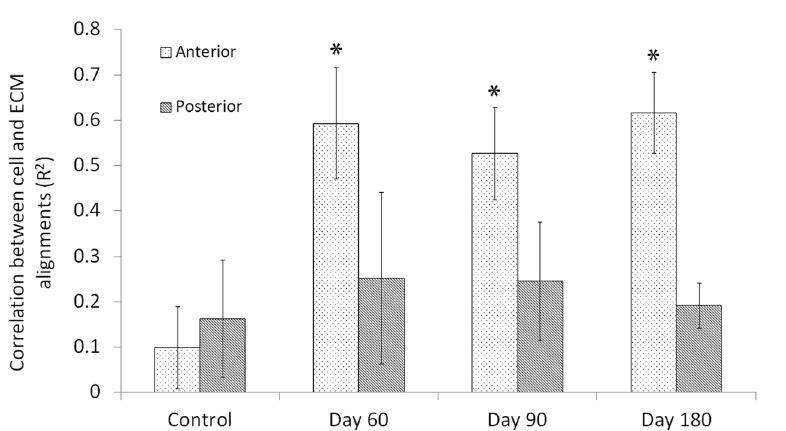
Figure 8. Quantitative analysis of cell/ECM co-alignment in the pre-operative anterior control stroma (control), regenerative anterior stroma (day 60, 90, and 180), and posterior stroma. ( * P < 0.001, ANOVA, when compared to anterior control